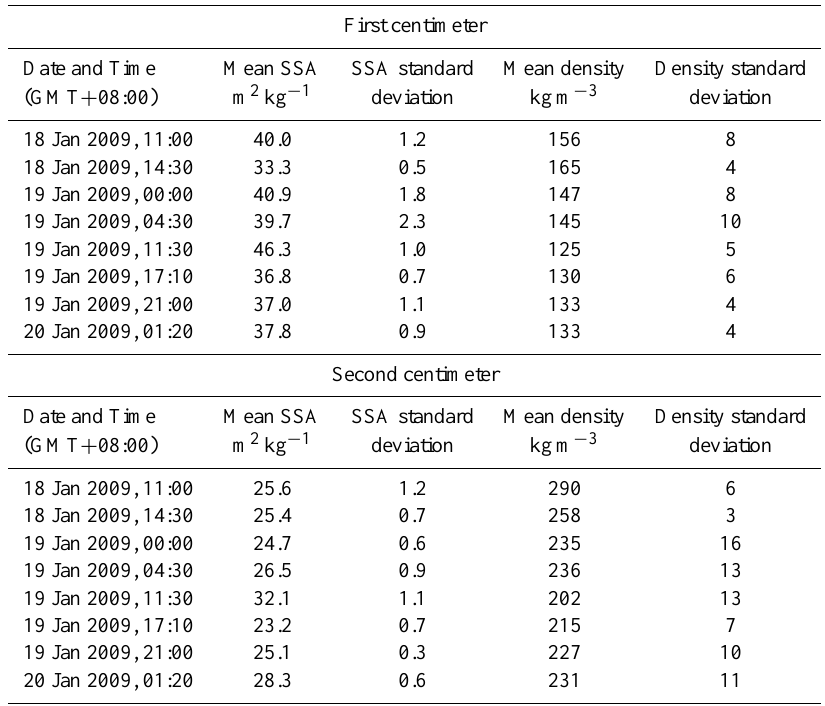
Table 1. SSA and density values used in DISORT for albedo calculations for 18–19 January. Standard deviations are calculated from triplicates measurements, for density and